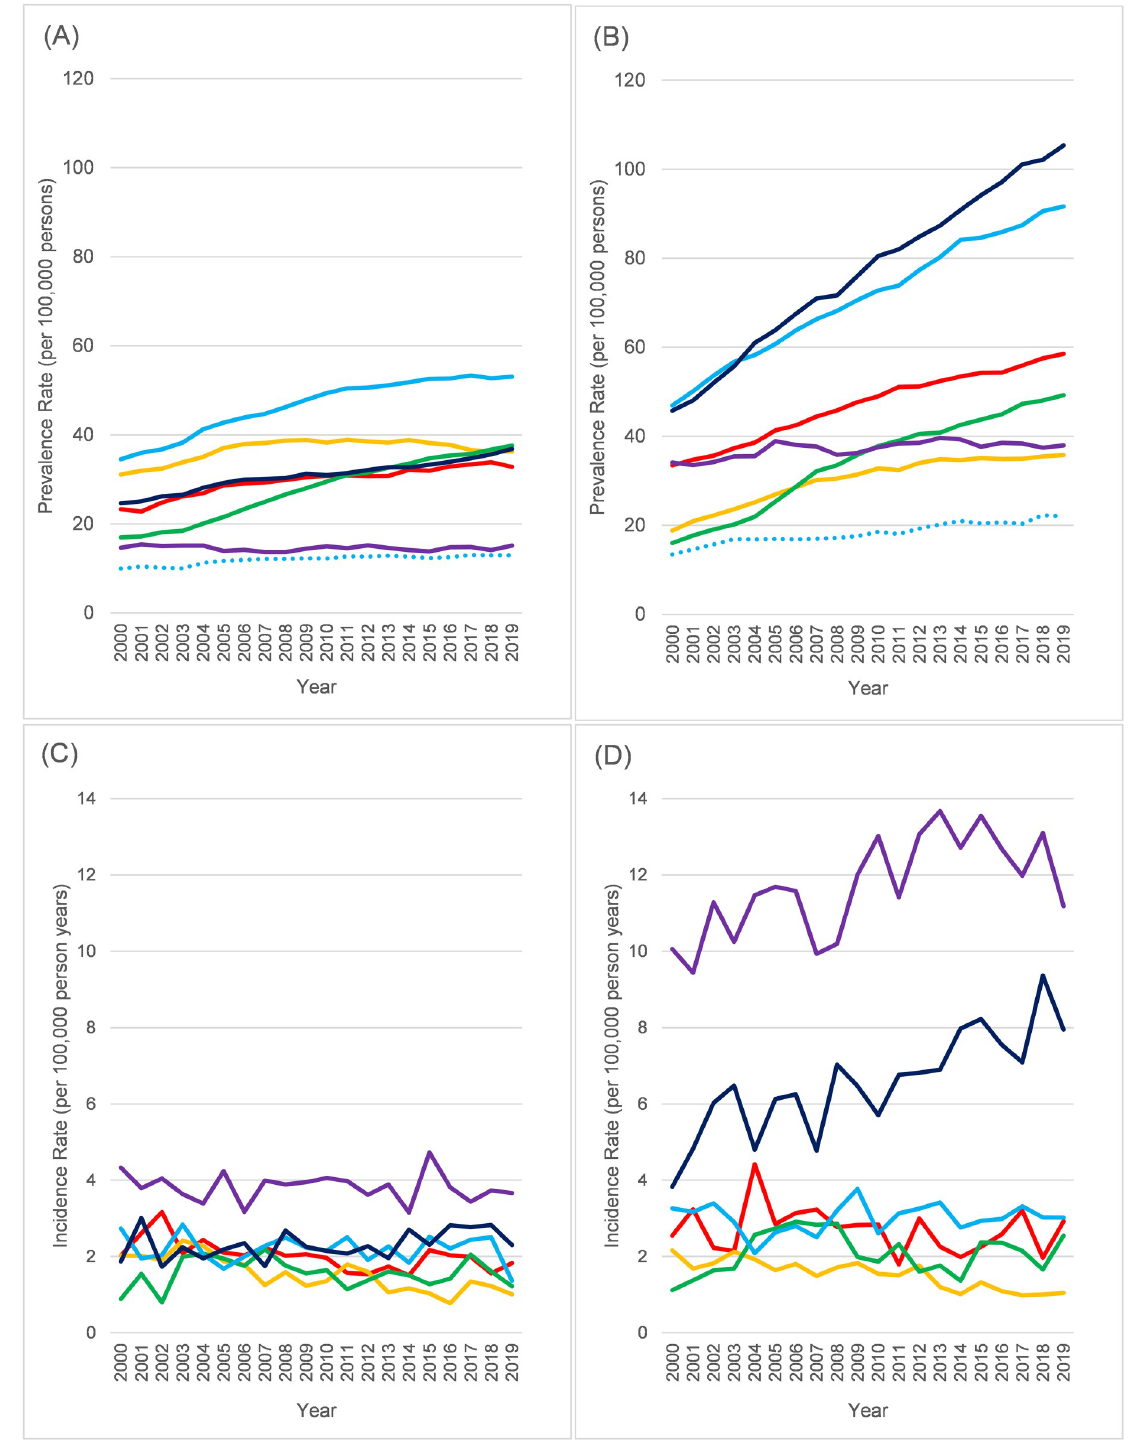
Fig 6. Time trends in neuromuscular disease 2000–2019 by selected condition, ages 45–99 only. (A) Prevalence in ages 45–64 years. (B) Prevalence in ages 65–99. (C) Incidence in ages 45–64 years. (D) Incidence in ages 65–99 years. Red = Inflammatory myopathies, Orange = Muscular dystrophies, Green = Charcot-Marie Tooth disease, Light Blue = Guillain-Barre´ syndrome, Dark Blue = Myasthenia gravis, Purple = Motor neurone disease. Solid lines = Lifetime, Dotted lines = excluding Guillain-Barre´ syndrome codes not recorded in last 5 years. All rates age standardised (within age-group) to CPRD population as of 1/1/2019.